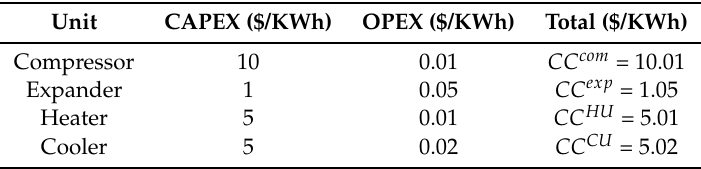
Table 4. CAPEX and OPEX Coefficients for Various Equipment Units.